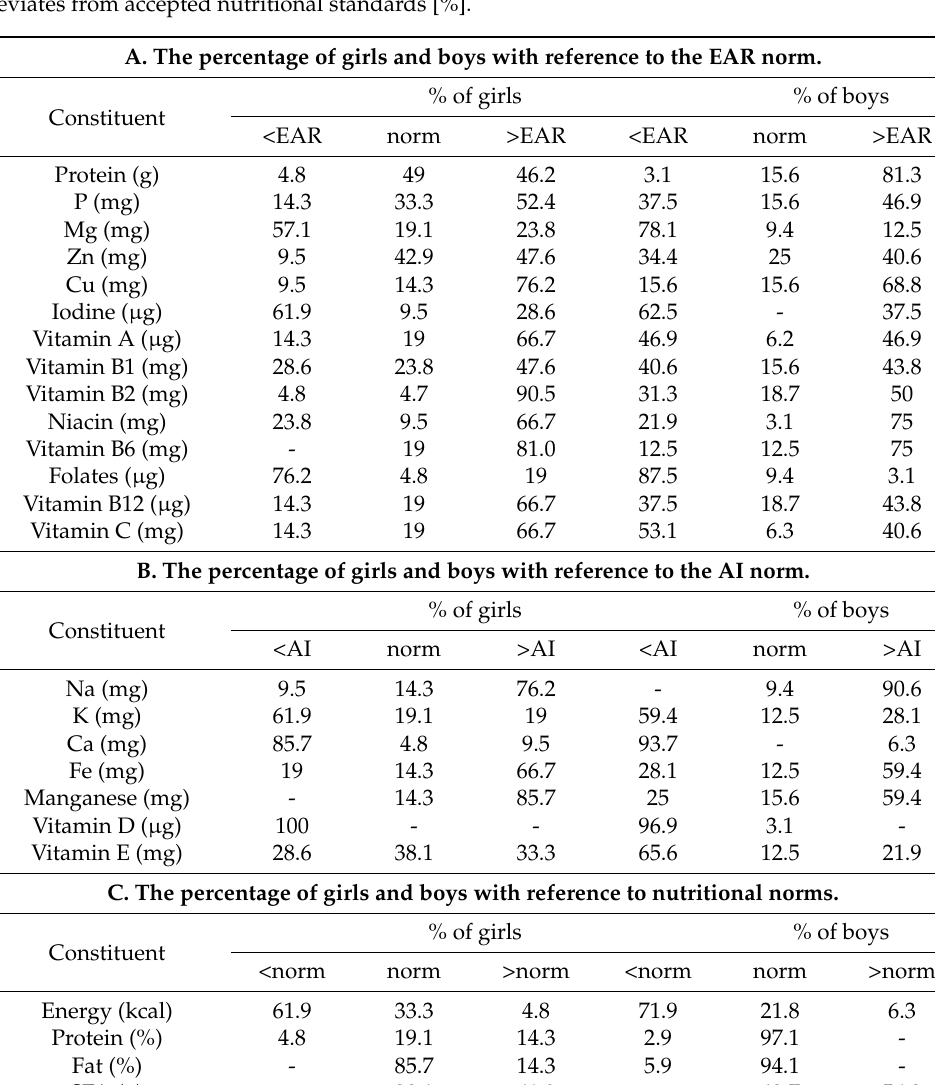
Table 1. The percentage of girls and boys in the study group among whom the intake of nutrients deviates from accepted nutritional standards